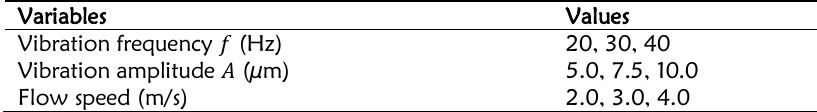
Table 1. A simulation procedure stopped when the 𝑦 -coordinate of particle center was larger than 0.3 mm, i.e. when the particle was flushed away from the electrode surface. Table 1 Boundary conditions in simulation